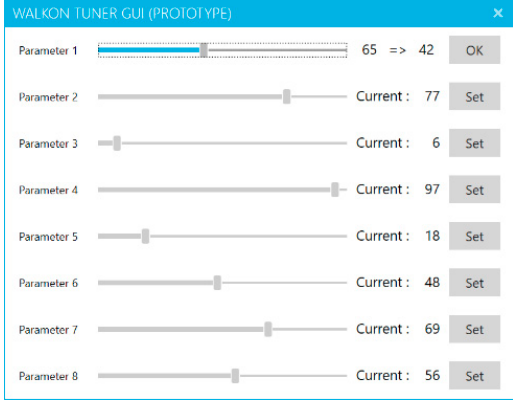
Figure 5. Schematic of the wearable robot’s component parameters based on component-processing- module results.